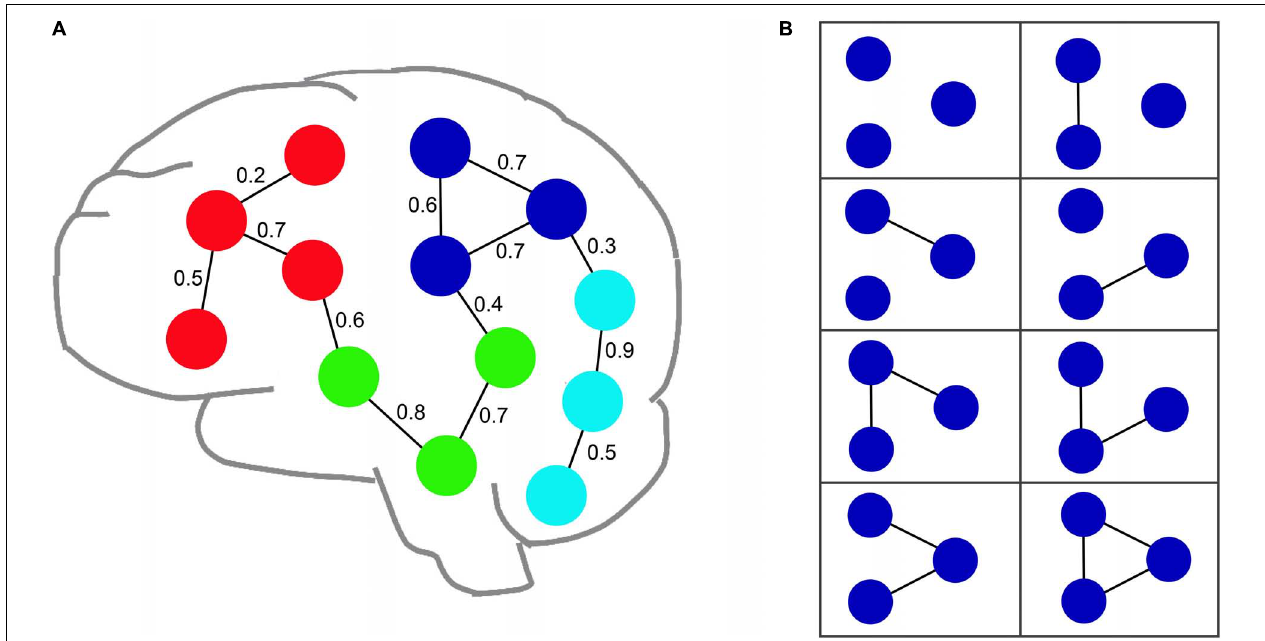
FIGURE 2 | An example of an uncertain fMRI brain network. (A) Illustrates an uncertain brain network with thirteen nodes and thirteen edges. The value of edge denotes the probability value of each edge. (B) Shows all possible instances for an uncertain graph composed of the blue nodes shown in (A) .